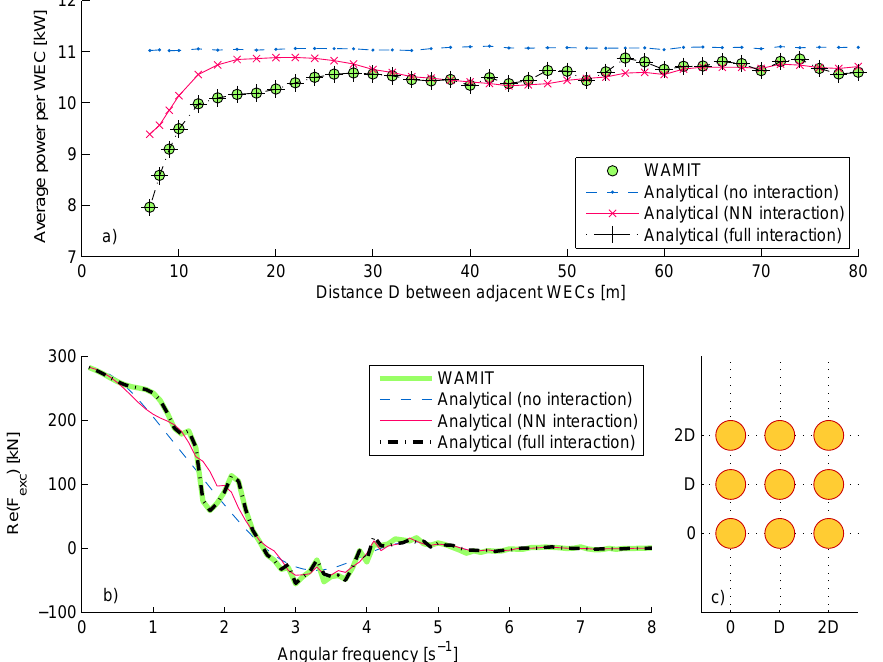
Figure 4. Accuracy of the analytical model, as compared to WAMIT. Simulations with the analytical model performed with no interaction, nearest neighbor (NN) interaction and full interaction between devices. ( a ) Average power per device in an array with nine WECs, as a function of separation distance D between adjacent devices; ( b ) The real part of the excitation force with increasing interaction distance cut-off; ( c ) The configuration of the